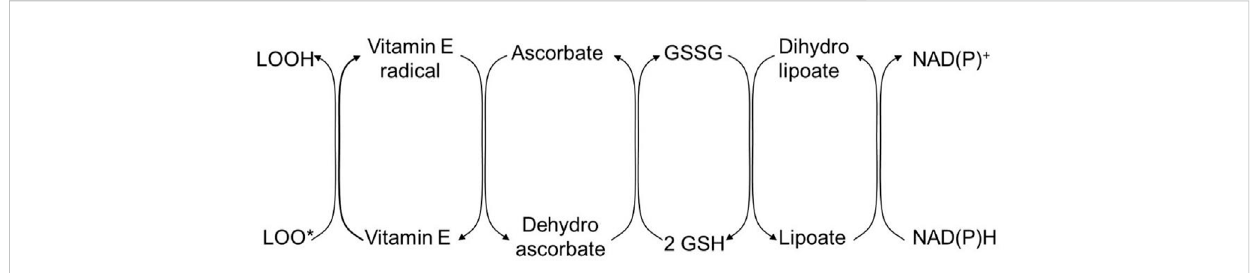
FIGURE 7 Schematic representation of the detoxi fi cation of oxygen radical originated from long-chain polyunsaturated fatty acids in the lipid phase to water- soluble harmless compounds such as NAD(P)H. LOOH, long-chain polyunsaturated fatty acid; LOO, radical of LOOH; GSH, glutathione; GSSG, oxidized glutathione; NAD(P)H, nicotinamide adenine dinucleotide